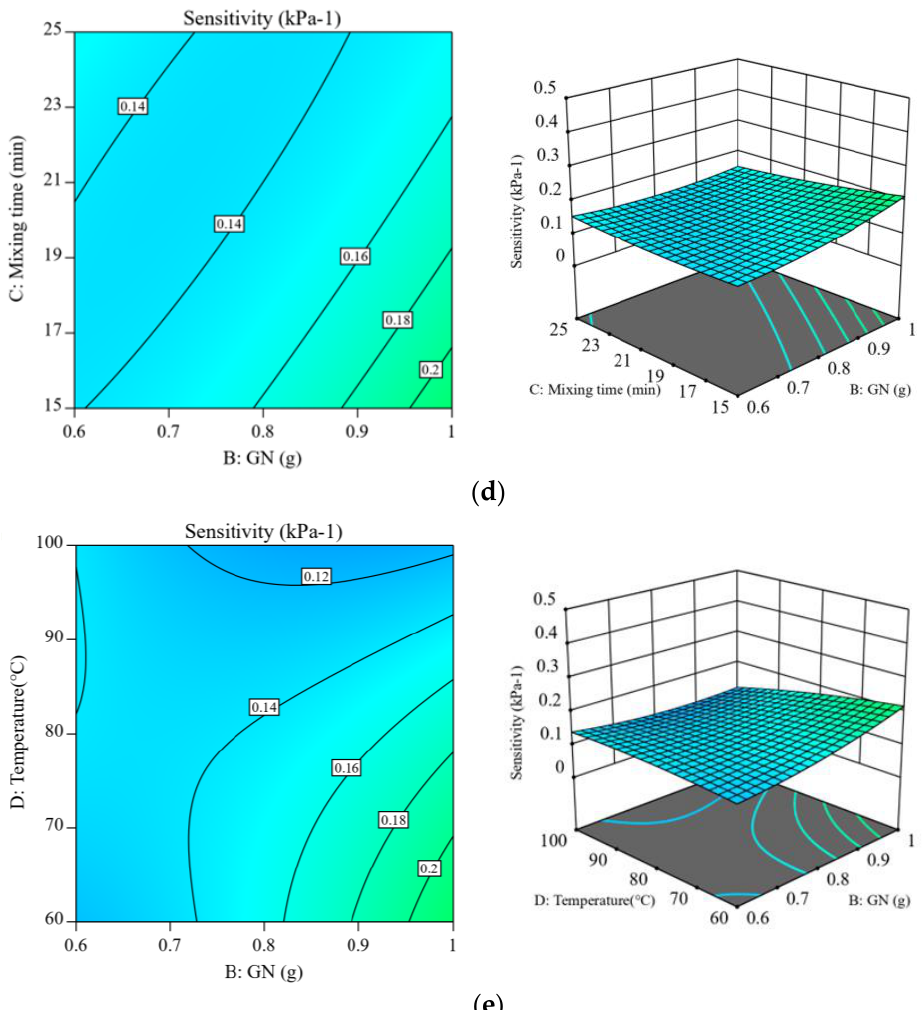
Figure 4. Studies of the relationships between ( a ) CNT and GN content, ( b ) CNT content and mixing time, ( c ) CNT content and curing temperature, ( d ) GN content and mixing time, and ( e ) GN content and curing temperature